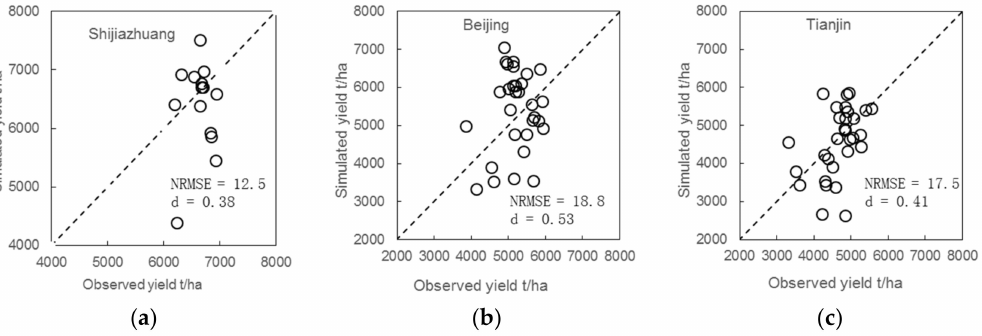
Figure 4. Calibration and validation results of yield for winter wheat. ( a – c ) are simulated yield for Shijiazhuang, Beijing, and Tianjin,